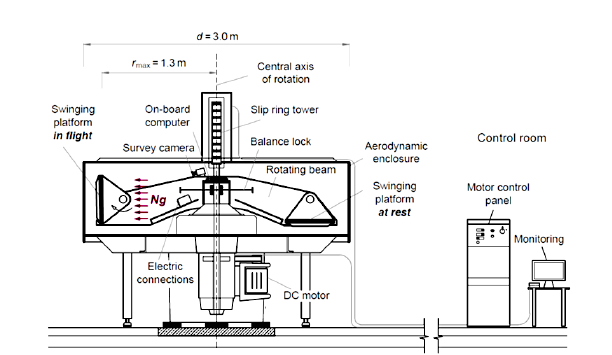
Figure 6. Geotechnical centrifuge at BOKU